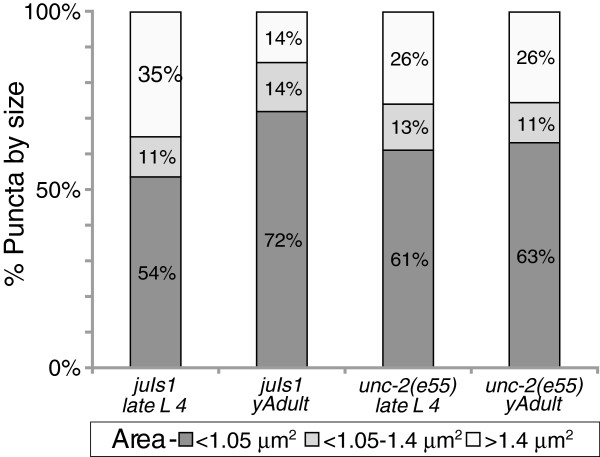
Presynaptic domains reshape during the 4th larval stage (L4) to adult transition. The proportion of puncta with an enlarged shape was analyzed. Puncta were binned into three categories based on the area [(<1.05, wild type like), (1.05-1.40, unc-2 like) and (>1.40, nid-1 like)]. During late L4 in wild type 35% of the puncta were enlarged and appeared nid-1 like, compared to only 14% in young adults. In contrast, the percent of puncta in unc-2 animals in any of the categories was not changed during the L4 developmental stage. N >150 puncta/genotype/stage.